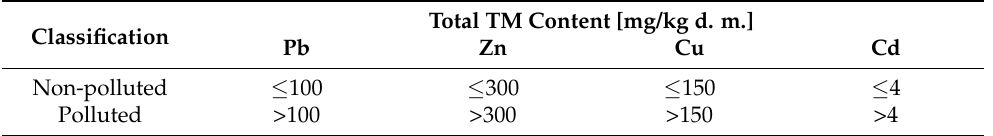
Table 3. Classification of soils for contamination with TM [45].